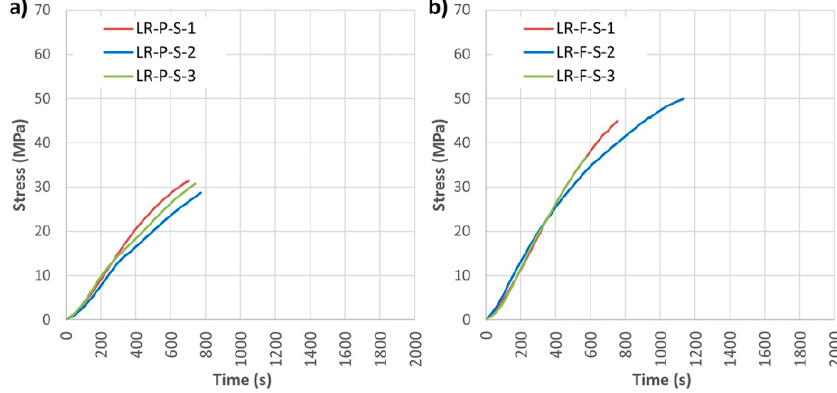
Figure 8. Bending stress against time for longitudinal reinforced beams (LR): ( a ) LR-P-S; and ( b ) LR-F-S. CFRP supplier: SIKA ® . Table 3. Mechanical results obtained from bending tests for LR-P-S and LR-F-S beams. Visual classification, MOR, density, density-corrected MOR, MOE, maximum deflection and type of failure. CFRP supplier: SIKA ® .